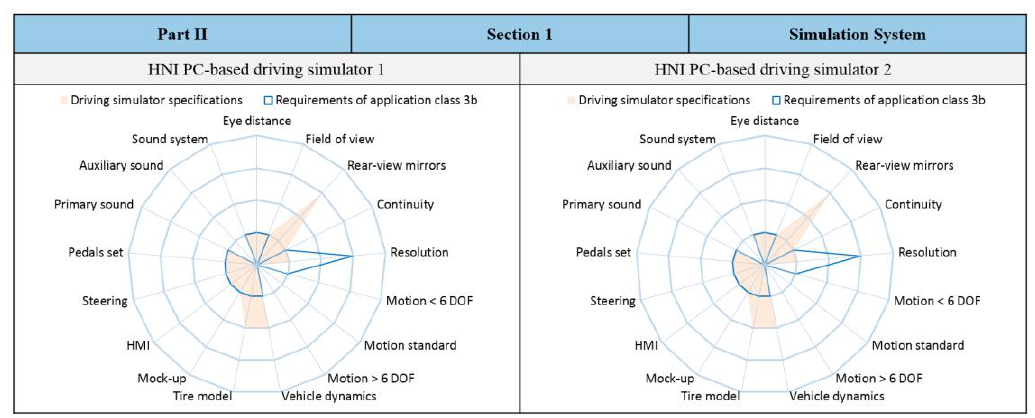
Figure 21. Specification/requirement radar charts of the selected simulation system components.